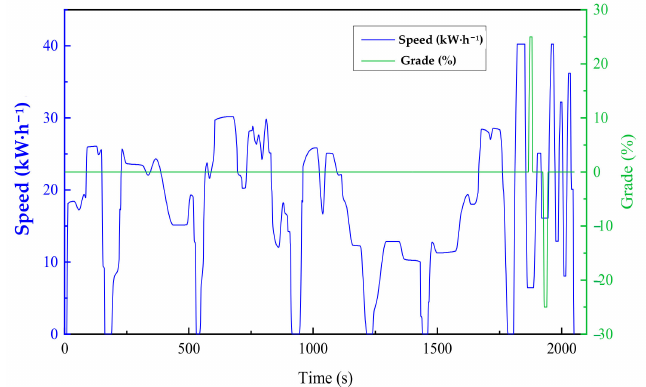
Figure 10. CYC_WCQ driving